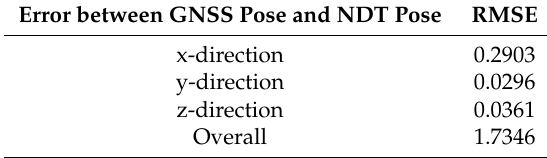
Table 2. Quantitative comparison between GNSS pose and NDT pose. RMSE is computed in x, y, and z direction respectively. The overall RMSE is also computed between the two poses.